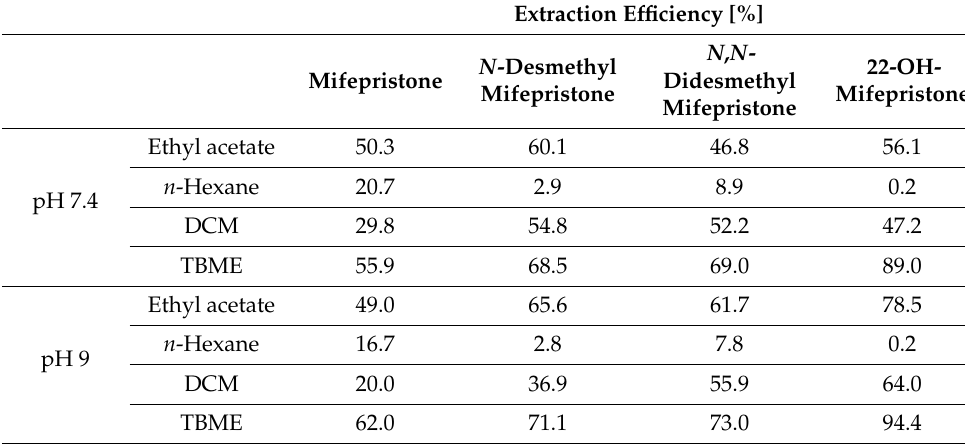
Table 2. Comparison of extraction efficiency [%] obtained for each compound in different pH conditions and with the use of various extraction